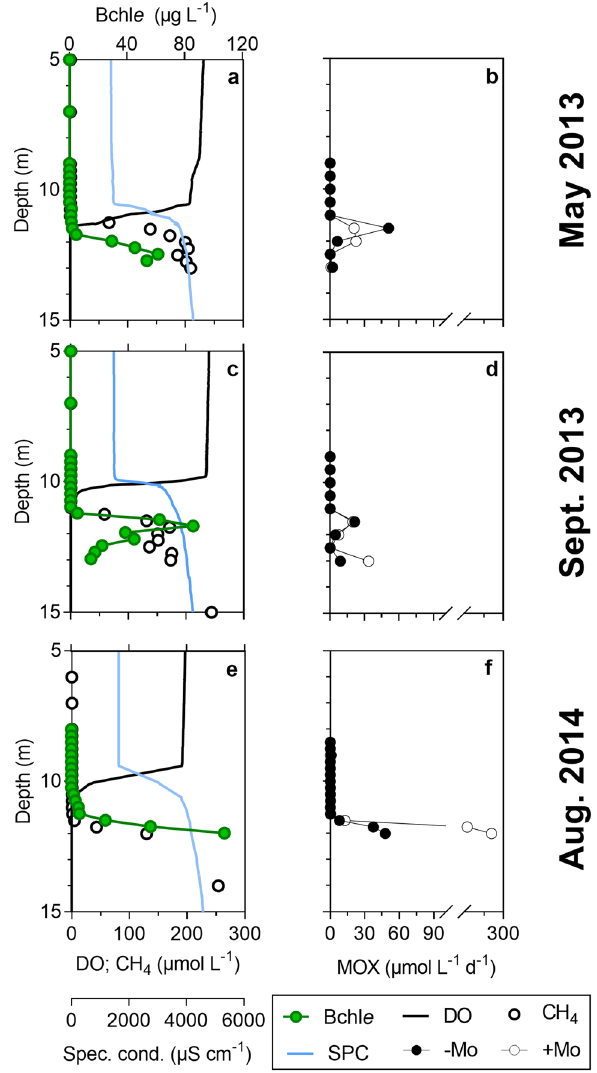
Figure 1. Physico-chemical conditions in Kabuno Bay are analogous to the Archean Ocean ( a , b : May 2013; c , d : September 2013; e , f : August 2014). ( a , c , e ): bacteriochlorophyll contents (Bchl e , µg L −1 ), dissolved oxygen (DO, µmol L −1 ) and CH 4 concentrations (µmol L −1 ), specific conductivity (SPC, µS cm −1 ). ( b , d , f ): methane oxidation rates (µmol L −1 d −1 ) without molybdate added (− Mo) and with molybdate added (+